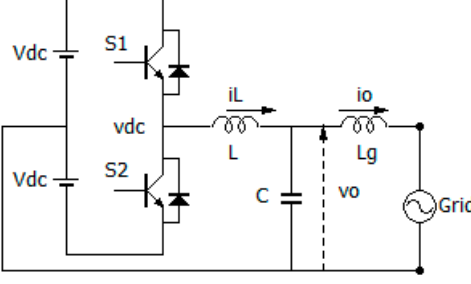
Figure 5. Grid-connected inverter circuit.